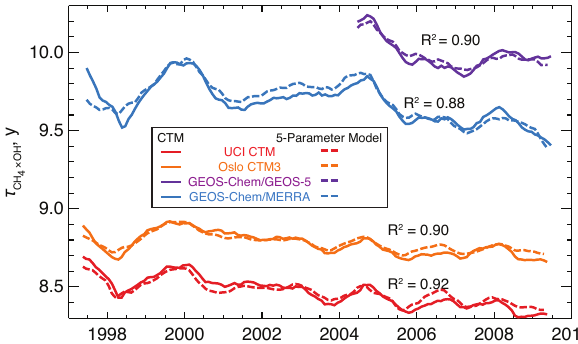
Fig. 1. Methane lifetime due to oxidation by tropospheric OH ( τ CH ) simulated by each CTM (solid lines) and reconstructed 4 × OH from the 5-parameter model (dashed lines). The parameters are air temperature, water vapor, ozone column, lightning NO x emission, and biomass burning emission. Parameter values for each CTM are given in Table 2 and the corresponding variables are in Fig. 3. R 2 values show correlation between each CTM and its own 5- parameter model. GEOS-Chem simulations use either MERRA or GEOS-5 meteorology. All lifetimes are smoothed with a 12-month running